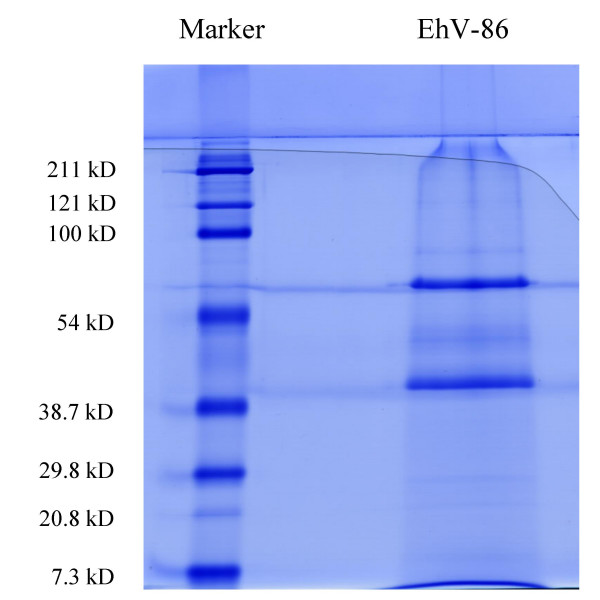
SDS PAGE of EhV-86 virion proteins.